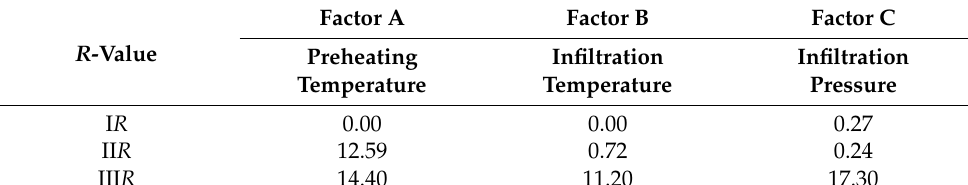
Table 4. R values for three factors.